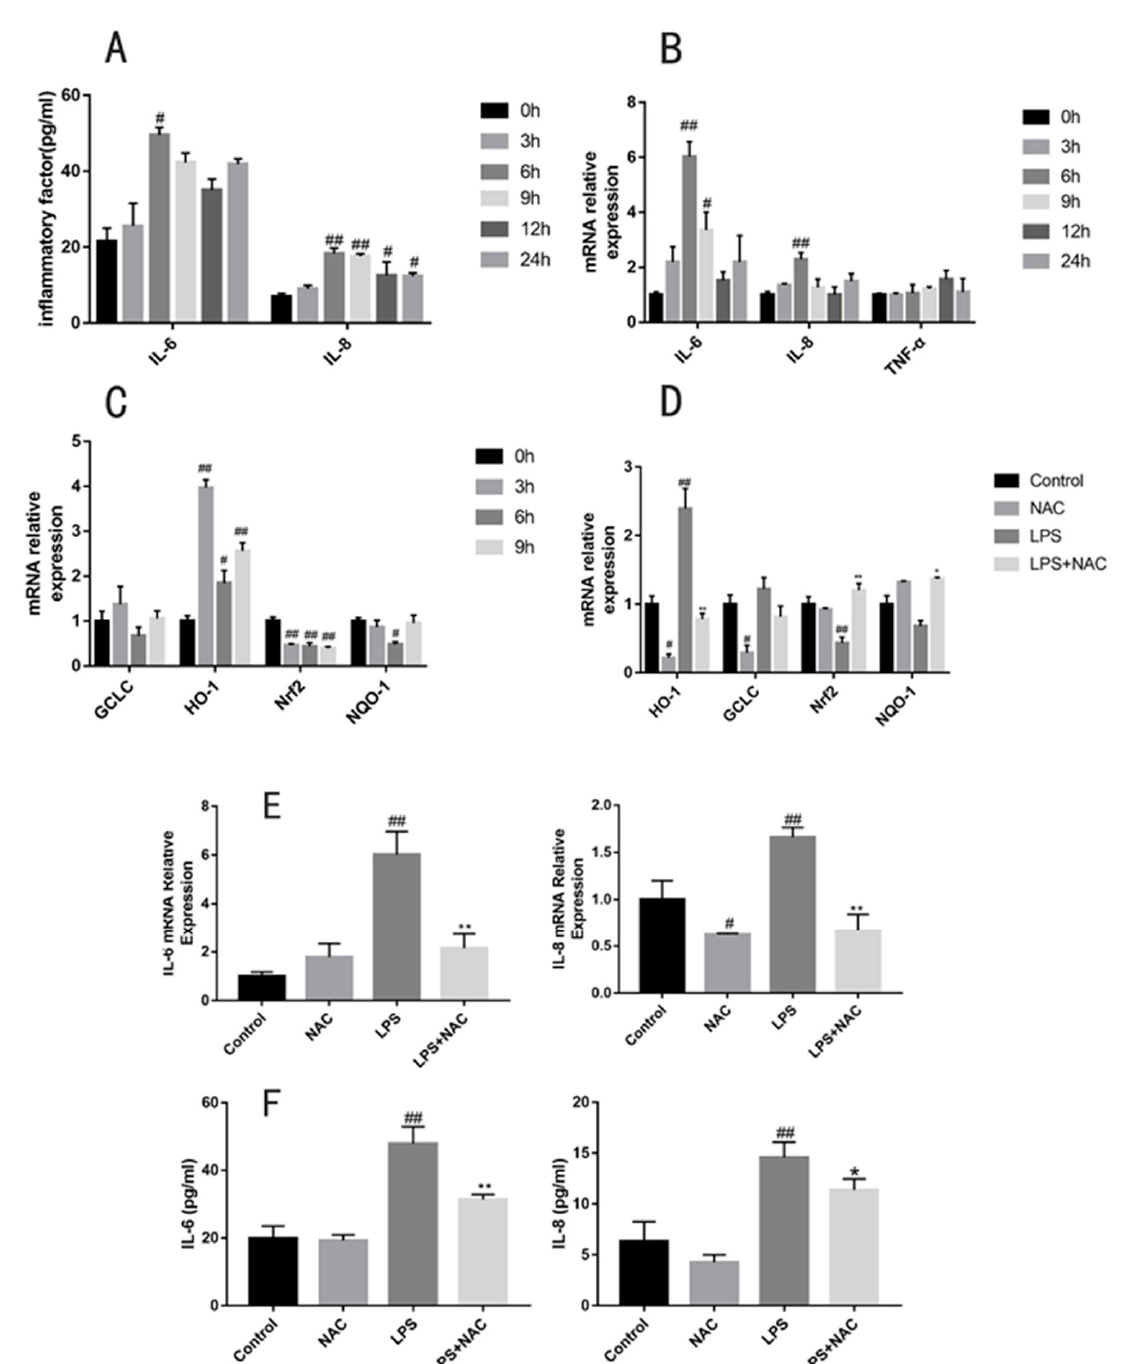
Figure 3. Gene expression and secretion of cytokines in bovine embryo tracheal cells (EBTr) exposed to LPS (4 µ g/mL) at different times. ( A ) Secretion of IL-6 and IL-8 and ( B ) gene expression of IL-6, IL-8, and TNF- α detected after treatment with 4 µ g/mL LPS for 0, 3, 6, 9, 12, 24 h. ( C ) Relative mRNA levels of antioxidants (GCLC, Nrf2, HO-1, NQO-1) were measured at 0, 3, 6, and 9 h of 4 µ g/mL LPS exposure. ( D ) Using q-PCR to detect antioxidant gene (GCLC, Nrf2, HO-1, NQO-1) expression changes after 1 mM NAC administration. NAC pretreatment significantly decreased ( E ) gene expression levels and ( F ) the secretion of IL-6 and IL-8. All results are expressed as the means ± SEM. ## indicates p < 0.01, # indicates p < 0.05 compared with the control group; ** indicates p < 0.01, * indicates p < 0.05 compared with the LPS group.